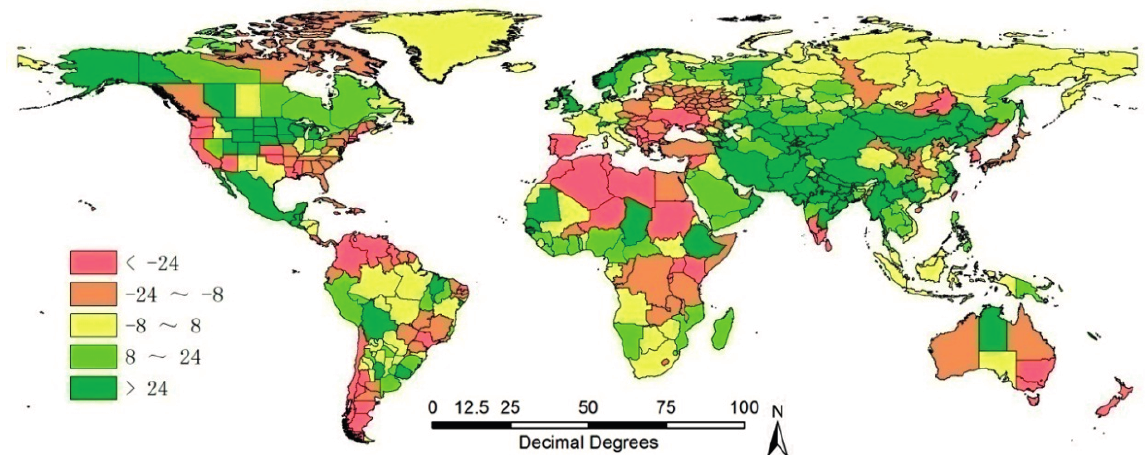
Figure 7. October 2013 to January 2014 global rainfall departure from the 2001–2012 average, by country and large administrative areas within large countries; the difference is expressed as percentage of the reference